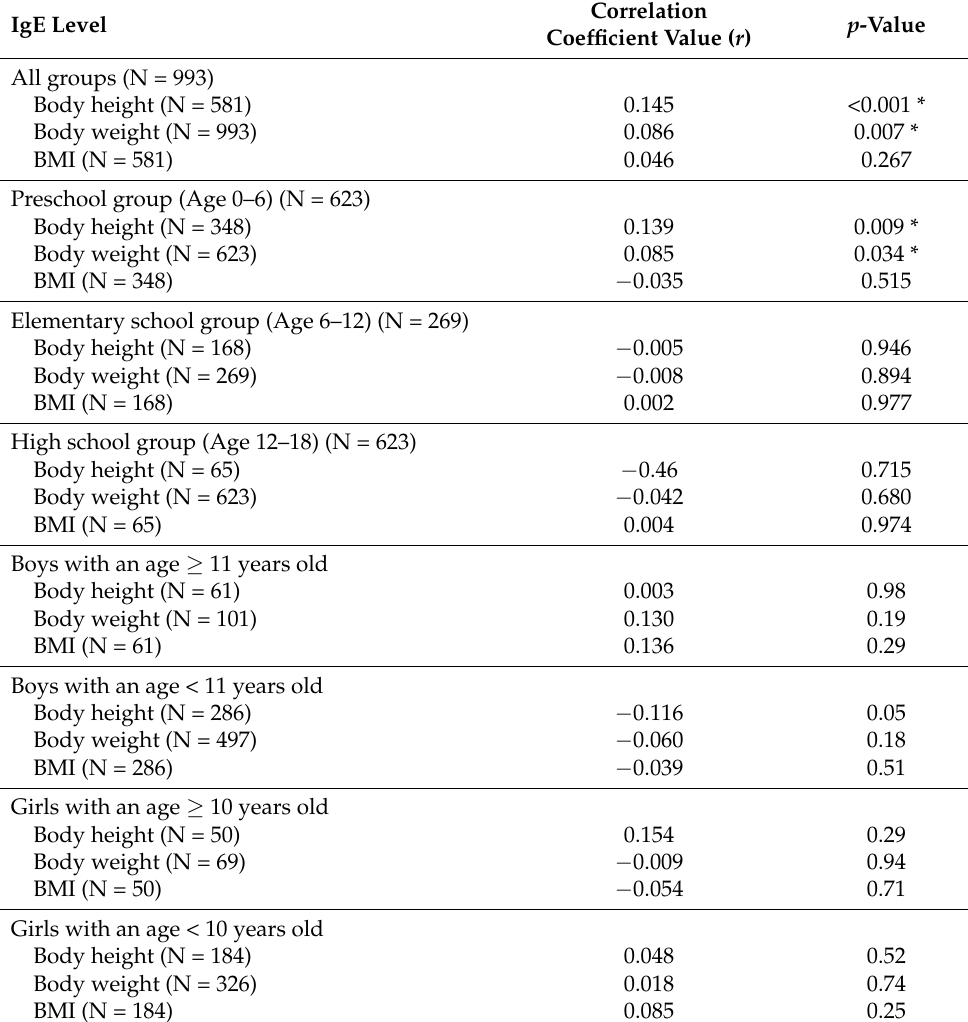
Table 2. The associations between serum total immunoglobulin (Ig) E levels, body weight, body height, and Body Mass Index (BMI).